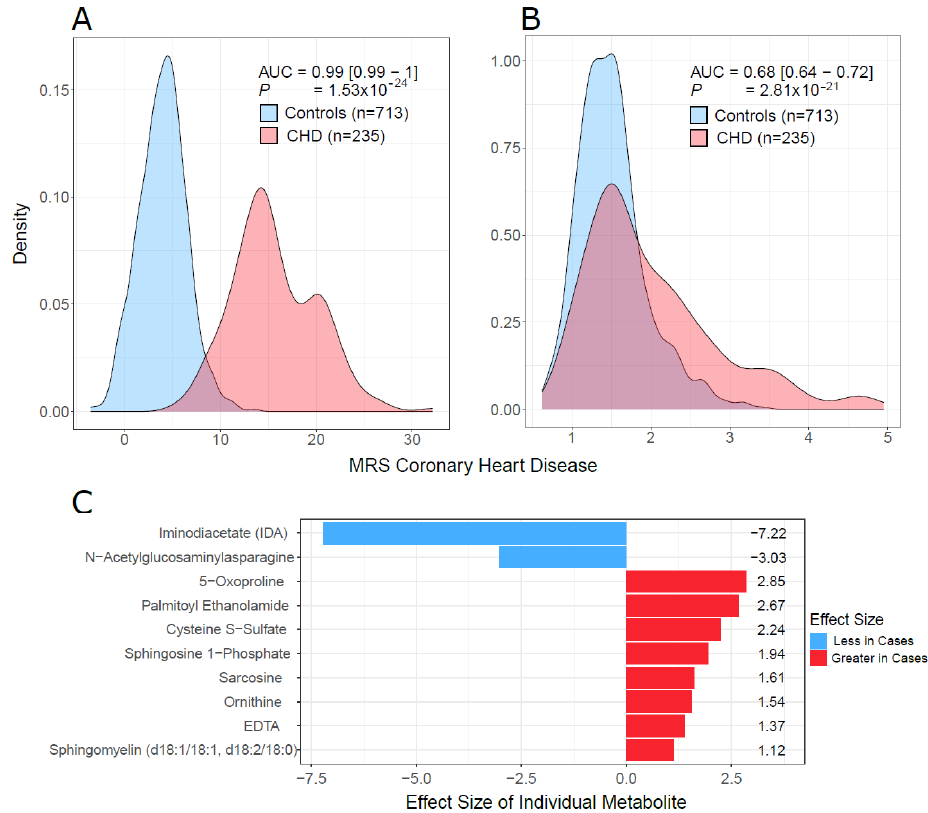
Figure 8. MRS discriminative performance. ( A ) Density plots of MRS10 in cases and controls in our test data. ( B ) Density plots of MRS19, which was developed by Wang et al. [13] on our test data. ( C ) The list of 10 metabolites used to build MRS10 using LASSO and their effect sizes. p (in ( A , B )) was the p value from the logistic regression: CHD Status ~ MRS+ age + sex + BMI. AUC = area under the receiver operating curve, was calculated for the model that only contained the MRS (omitting all covariates) because of unbalance of cases and controls with respect to covariates.